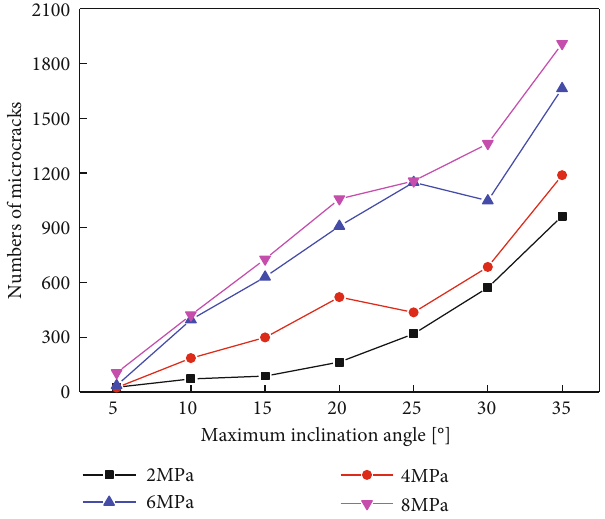
Figure 10: The in fl uence of maximum inclination angle of joint on number of